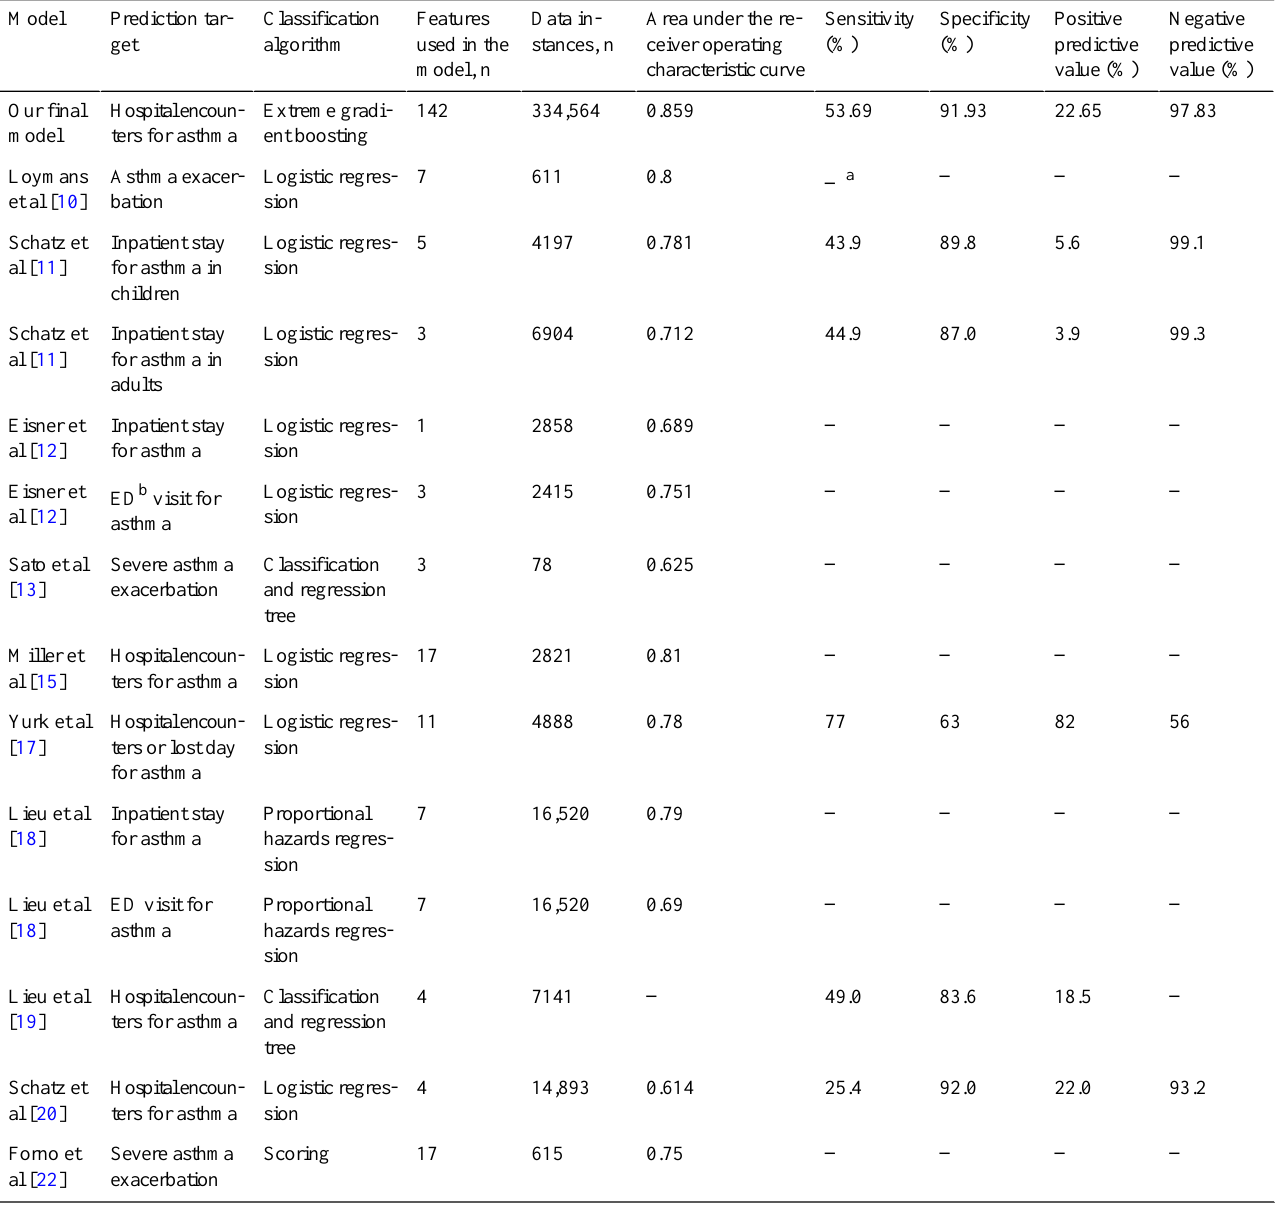
Table 6. A comparison of our final model and multiple prior models for predicting inpatient stays and emergency department visits in asthmatic patients.